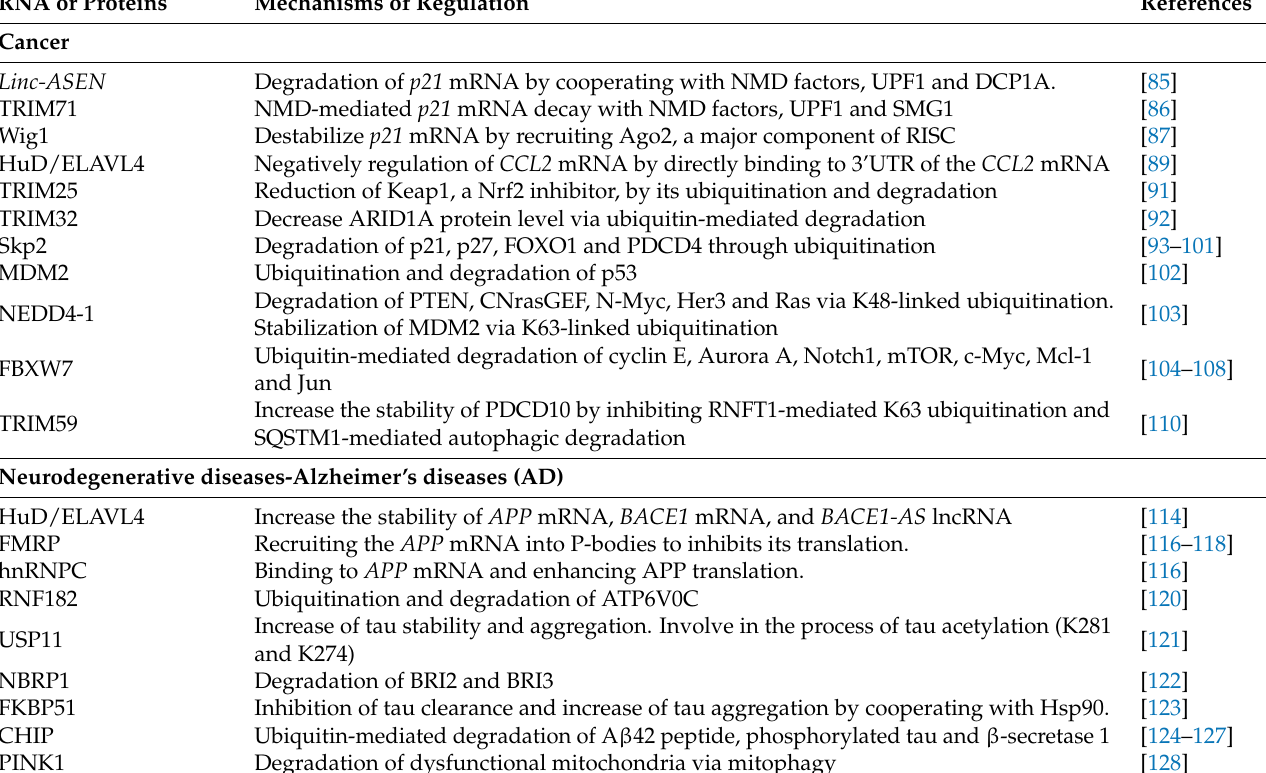
Table 1. Molecular pathways of RNA and proteins related to age-related diseases. RNA or Proteins Mechanisms of